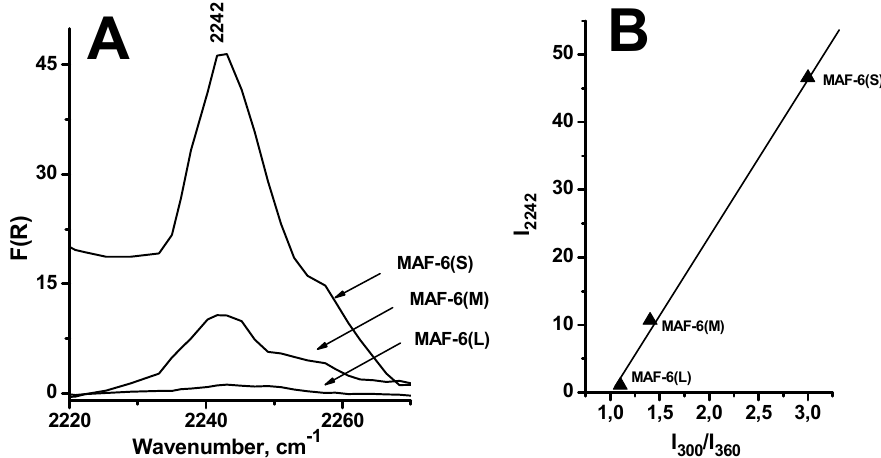
Figure 5. ( A ) DRIFT spectra of CDCl 3 adsorbed on MAF-6 with different particle sizes. ( B ) Correlation between I 300 /I 360 and the number of basic sites (I 2242 ).